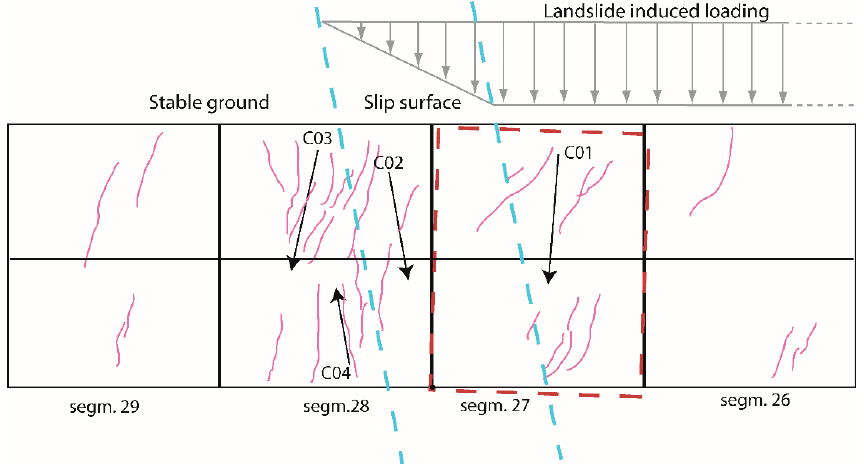
Figure 12. Landslide: estimated loading scheme and tunnel response.